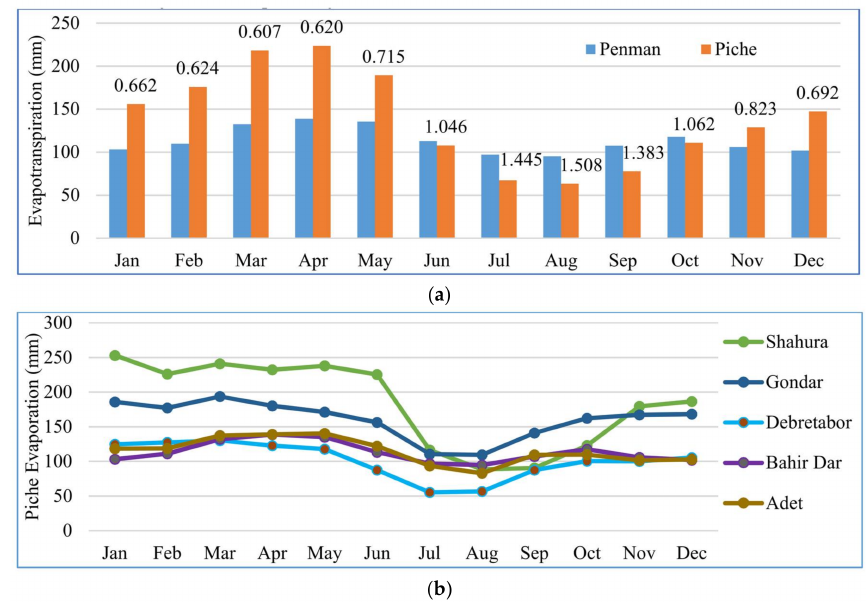
Figure 9. Evapotranspiration ( a ) Piche evaporation adjustment; ( b ) adjusted Piche evaporation.